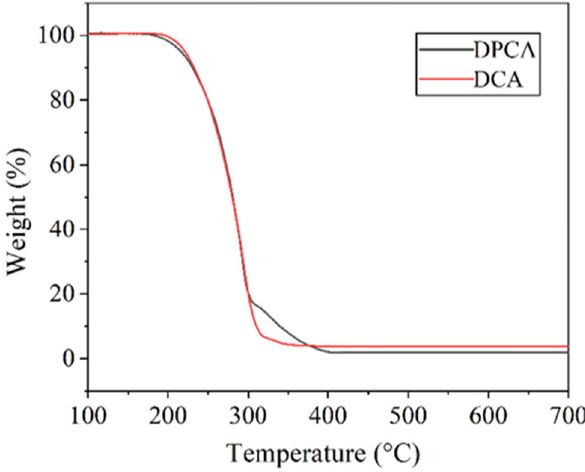
Figure A1: TG curves of DCA and DPCA under nitrogen conditions.